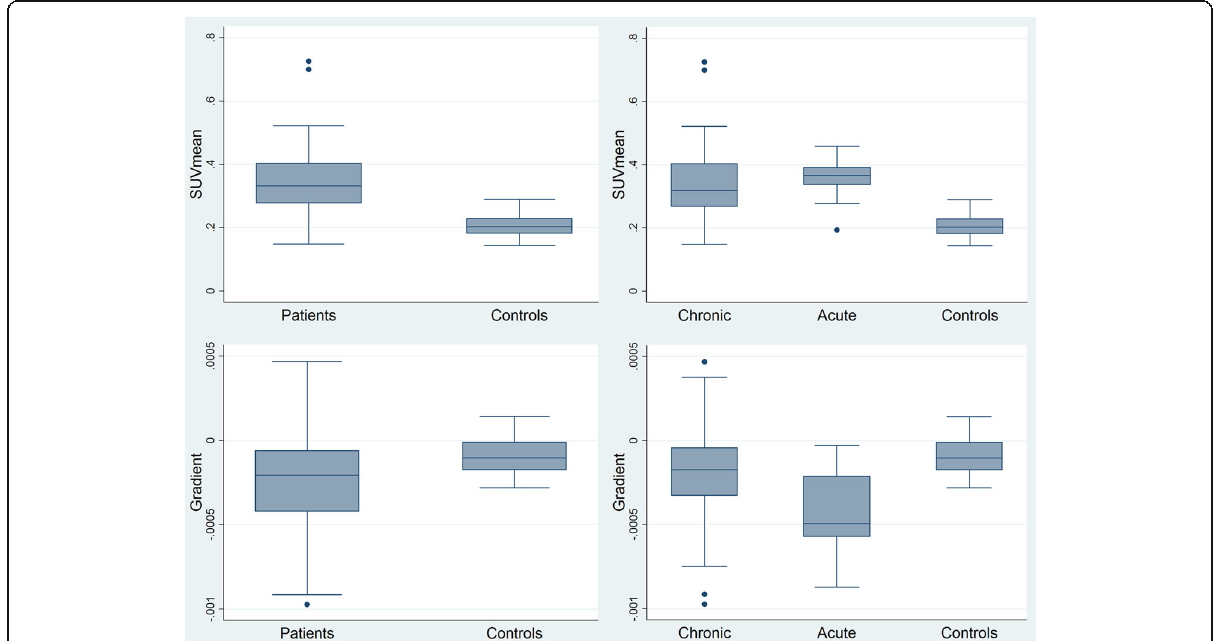
Fig. 3 Muscular 99m Tc-PYP uptake in thigh muscles of patients with idiopathic inflammatory myopathy versus controls. Upper row: SUV mean . Lower row: 99m Tc-PYP gradient. Left column: all patients versus controls. Right column: chronic patients, acute patients, and controls. Boxes show median and upper and lower quartiles. Whiskers mark the highest value within the 3rd quartile + 1.5 times the interquartile range (IQR) and the lowest value within the 1st quartile − 1.5 IQR, whereas observations being either larger or smaller than those were defined as outliers and plotted as individual points